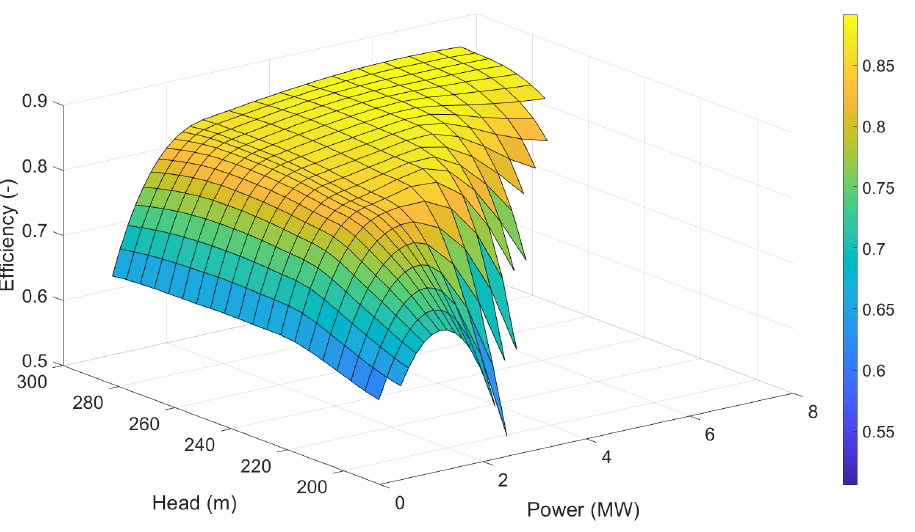
Figure 16. Extended hillchart of the Pelton turbine including the region where the “falaise” effect occurs. The amplitude of the accelerometer signal along the x-direction as a function of the head is shown in Figure 17 for the three peaks. Below a head of 215 m, the amplitude increases by a factor of 4, which corresponds to the region where the efficiency drops below 0.75 (see Figure 15 at the top). The spectrogram of the signal during the third peak is plotted in Figure 18 within the addition of the time history of the head. It is noticeable that the power of all the frequencies increases when the head decreases below approximately 230 m, which corresponds to the beginning of the “falaise” effect. The constant high amplitude at 800 Hz corresponds to the bucket passage frequency.